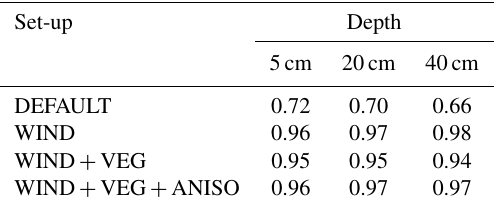
Table 1. Nash–Sutcliffe model efficiency criteria (Nash and Sut- cliffe, 1970) between the soil temperature simulations and measure- ments at different depths in the grass centre of the reference poly- gon.